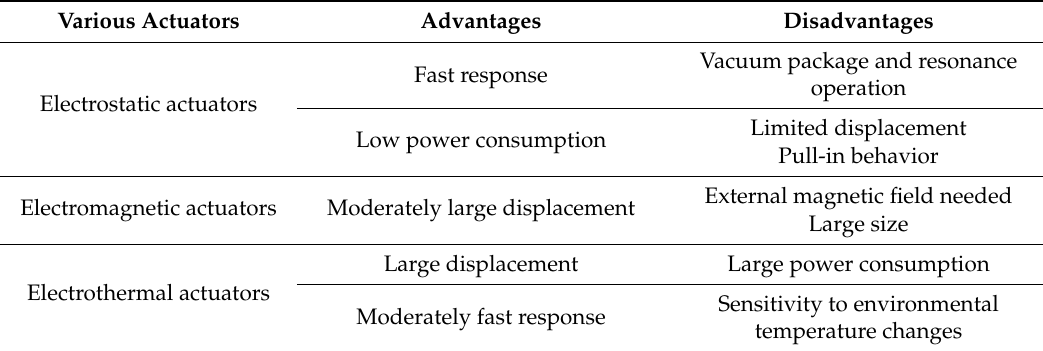
Table 4. Comparison of various